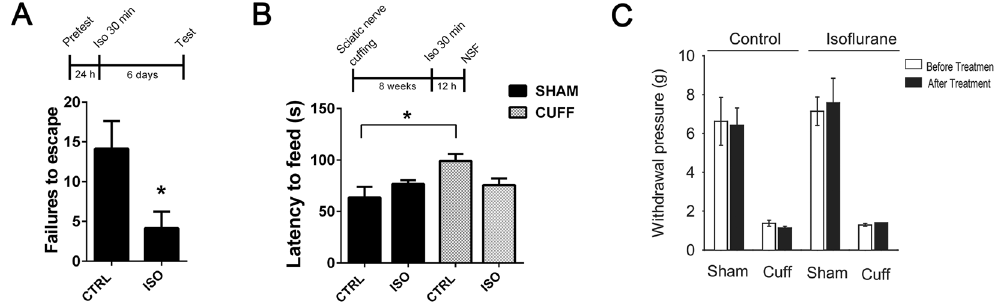
Figure 1. A single brief isoflurane anesthesia produces antidepressant-like behavioural effects in rodents ( A ) A single isoflurane anesthesia (30 min) decreases the escape failures in the learned helplessness test when tested 6 days after the anesthesia (p = 0.0296; n = 7). ( B ) Mice subjected to right common sciatic nerve cuffing show anxiodepressive behaviour (increased latency to feed) in the novelty suppressed feeding test. Such phenotype is not seen in mice exposed to a single isoflurane anesthesia (30 min) at 12 hours before testing (two-way ANOVA: cuffing * treatment interaction F 3,27 = 6,398, p = 0.018; n sham ctrl = 8, n sham iso = 8, n cuff ctrl = 8, n cuff iso = 7). ( C ) Control and isoflurane-treated mice subjected to the right sciatic nerve cuffing show essentially similar mechanical allodynia in the von Frey test 8-weeks post-surgery (Two-way ANOVA: surgery F 1,24 = 123.19, p < 0.001, treatment F 1,24 = 0.52, p = 0.47, surgery x treatment interaction F 1,24 = 0.006, p = 0.93). The experiment was performed 3 days before and 2 days after control or isoflurane treatment. * p < 0.05, ** p < 0.01;